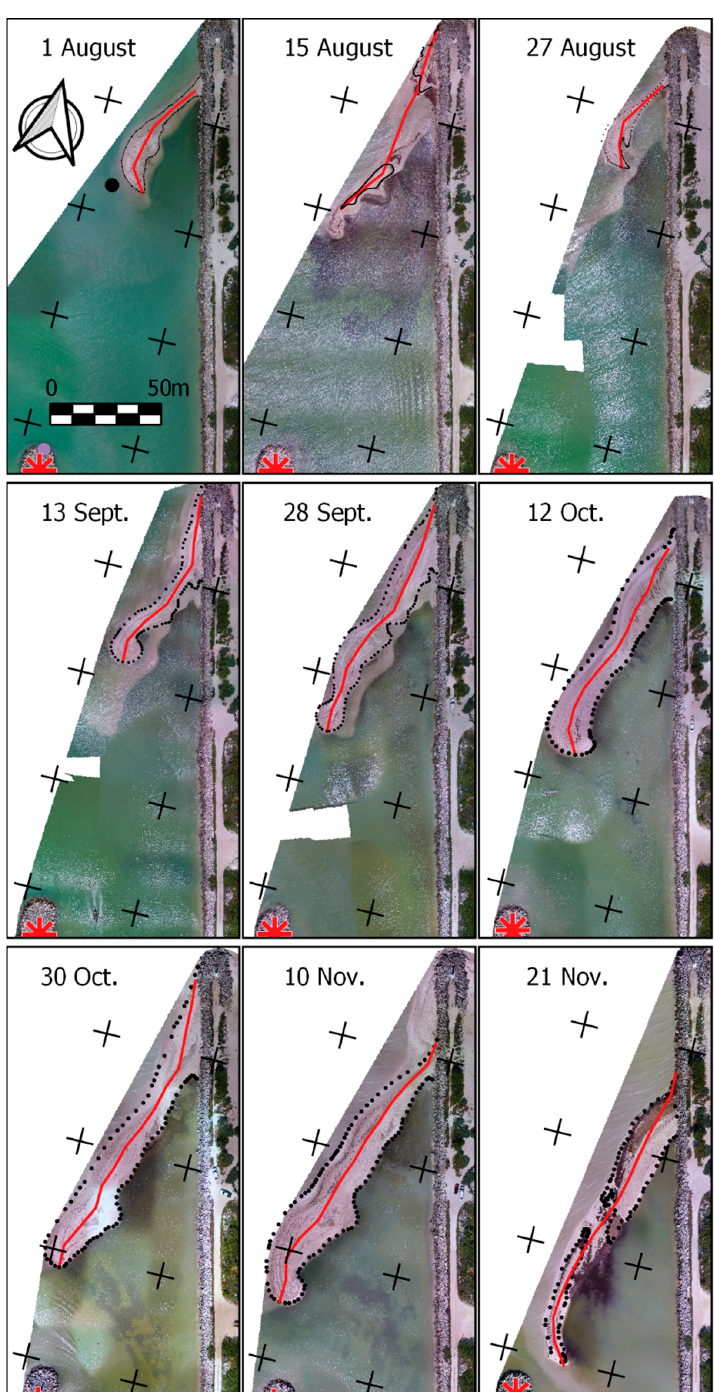
Figure 3. UAV images showing the evolution of the sand spit. The numbers are month/day of 2018. The red asterisk is the reference point. Crosses in each panel are 50 m apart in XY direction. The red lines show the center (midline) of the spit, and the black dotted lines correspond to the elevation Z = − 0.2 m. The black dot in the first panel is a reference point used to compute the spit position and displacement.